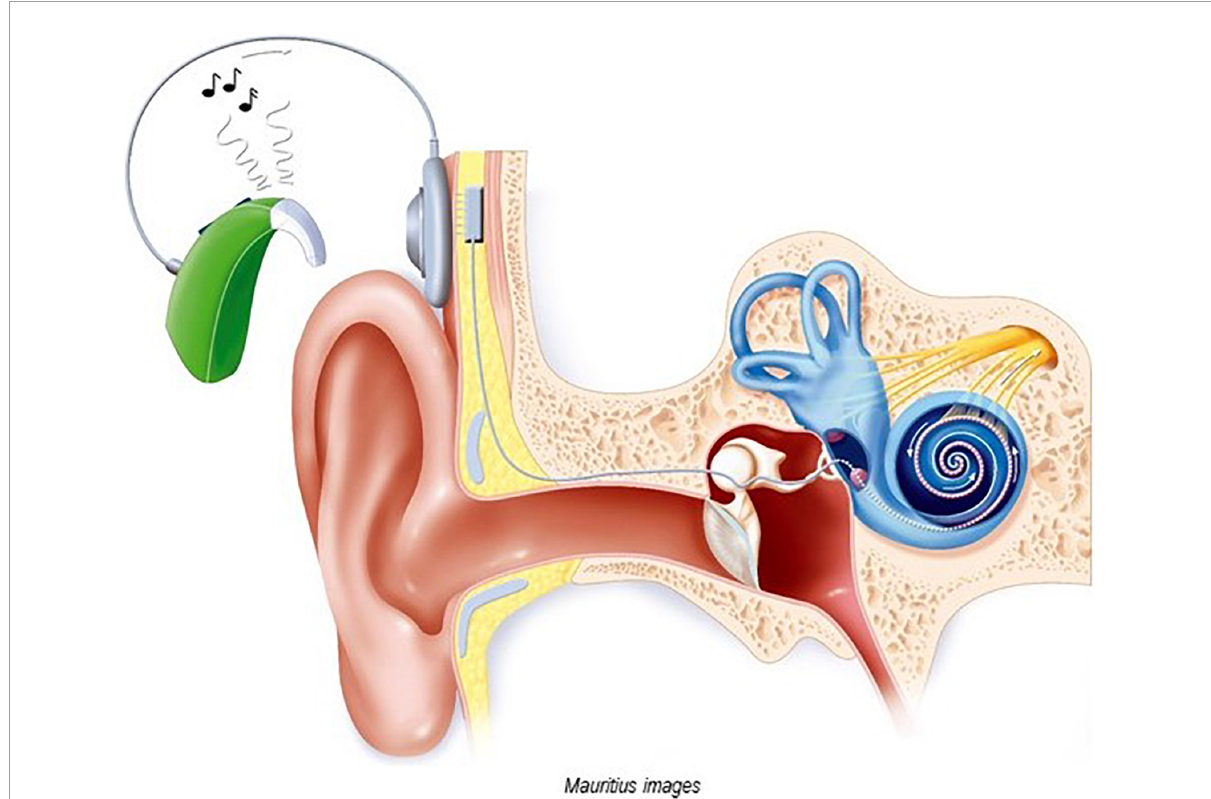
FIGURE1 Image of a cochlear implant (with permission of Mauritius Images, Kd 55911). The external sound processor converts sound into a sequence of electrical impulses and sends these signals via a transmitter coil to the internal receiver-stimulator. The internal device, which is located under the skin in a cavity created in the skull bone, processes the electrical signal and transmits them via electrodes to the spiral ganglion cells of the cochlear nerve. Both internal and external devices are equipped with